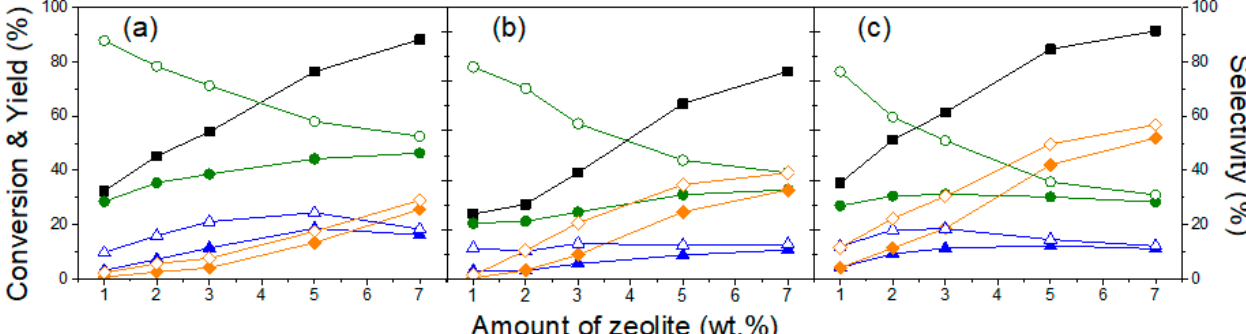
Figure 3. The influence of the amount of ( a ) XZ-Li, ( b ) XZ-Na and ( c ) XZ-K on the etherification reaction of glycerol (- ■ -: conversion of glycerol, - ● -: yield of DG, - ▲ -: yield of TG, - ♦ -: yield of others - ○ -: selectivity of DG, - Δ -: selectivity of TG, - -: selectivity of others, reaction temperature: 260 °C, reaction time: 6 h).